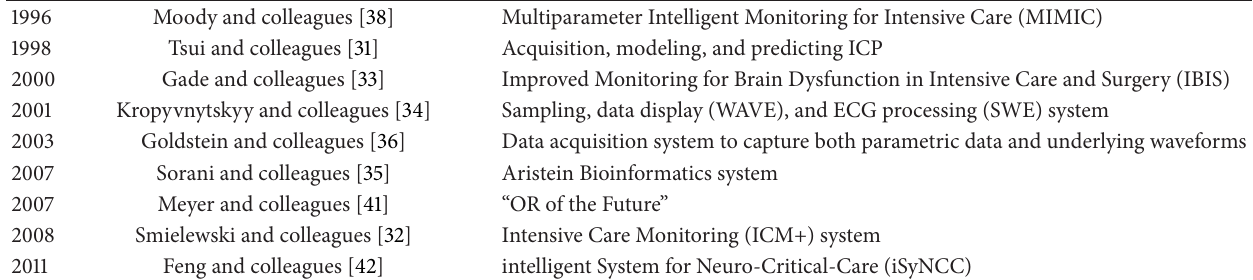
Table 2: Data acquisition and integration systems for